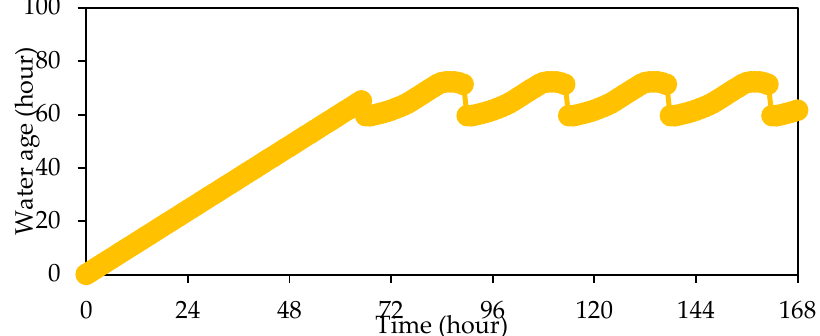
Figure 5. Water age at Mukono Health Centre (No. 13), the highest value in the system.